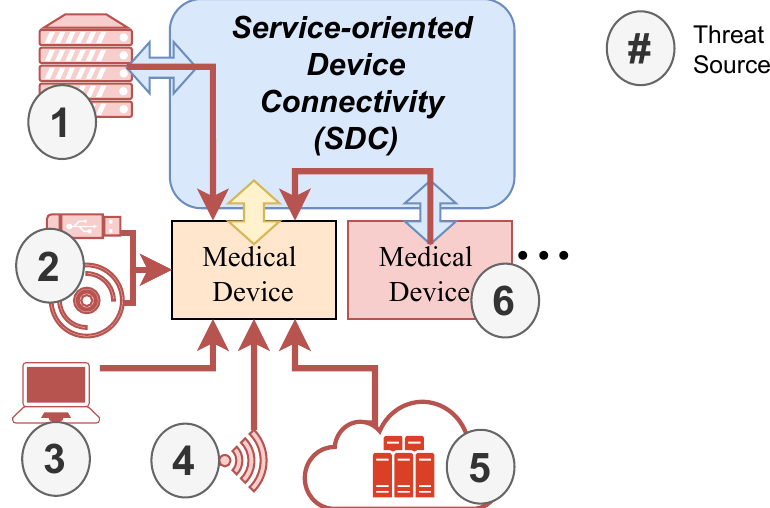
Figure 5. Threat landscape in an Operating Room (OR) network of medical devices based on the overall concept for SDC [94] with different threat sources